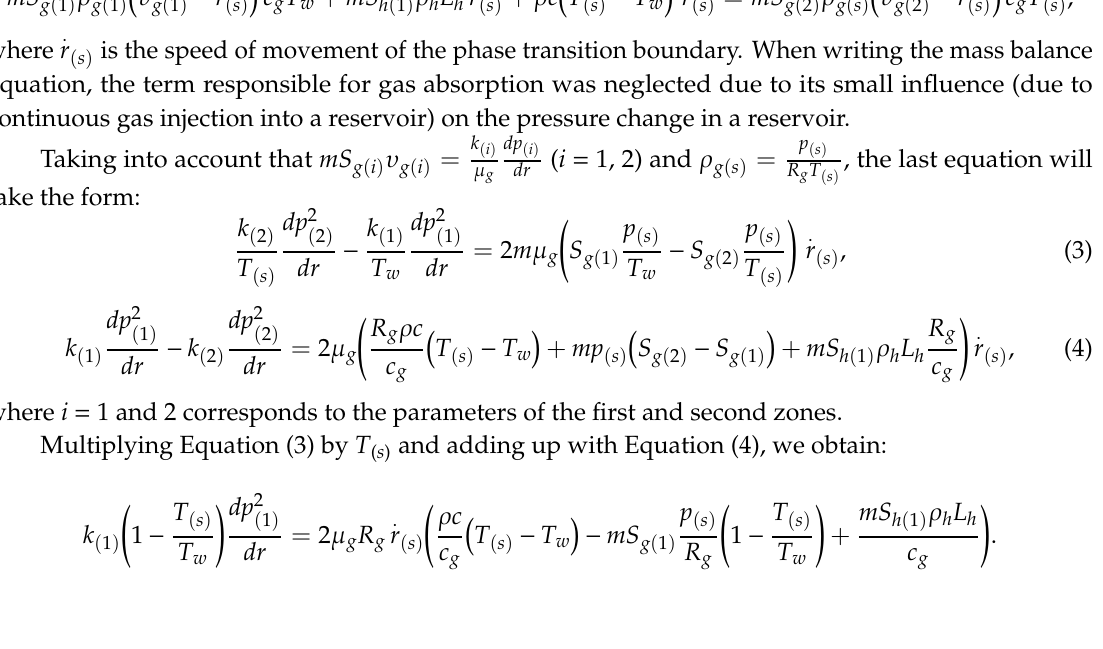
Figure 3. Schematic temperature distribution in a reservoir.